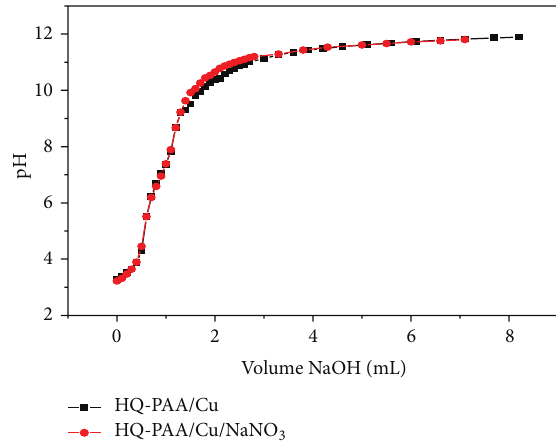
) for HQ-PAA/Cu(II) and HQ- NaOH